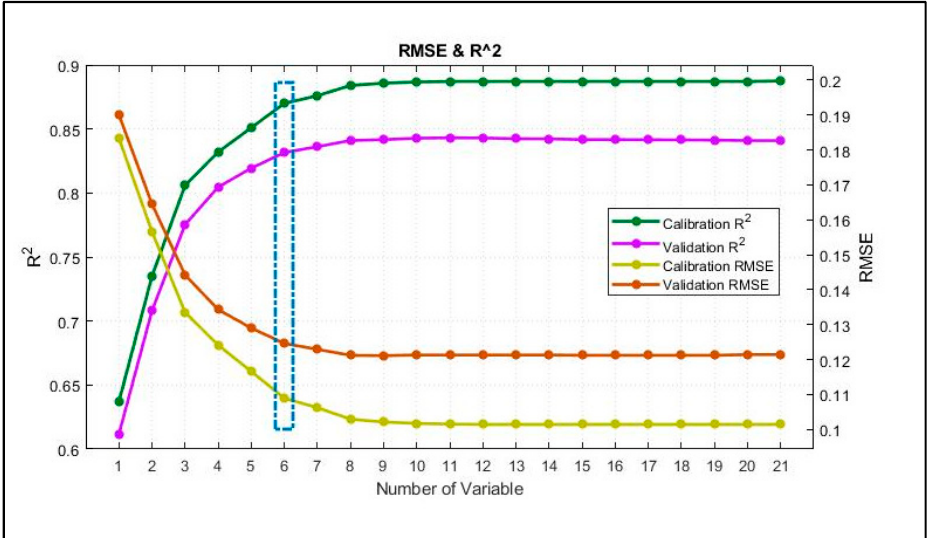
Figure 3. The RMSE and R 2 plot. The RMSE is decreasing as the number of latent variable increases. After a certain number of latent variables, the decrease in RMSE was negligible and that was taken as the optimum number of variables for PLSR model development.